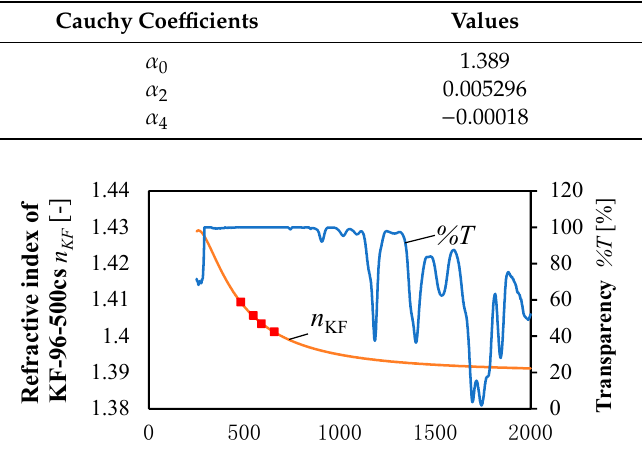
Table 3. Estimated Cauchy coefficients for KF-96-500cs.